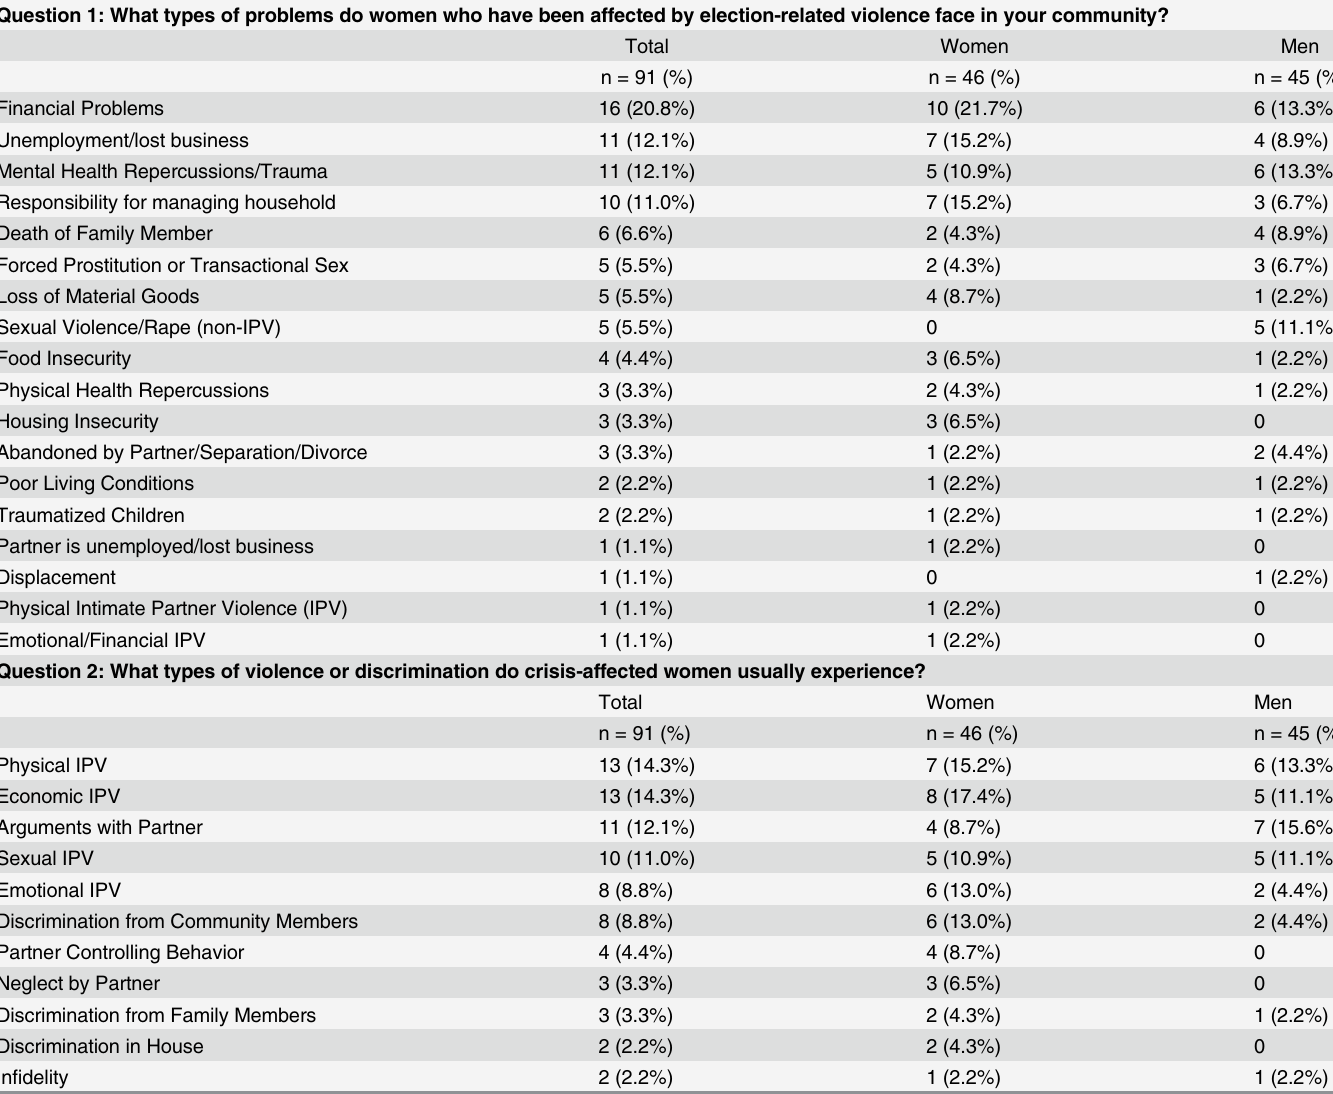
Table 1. Free Listing Results from Focus Group Interviews by Gender (n =